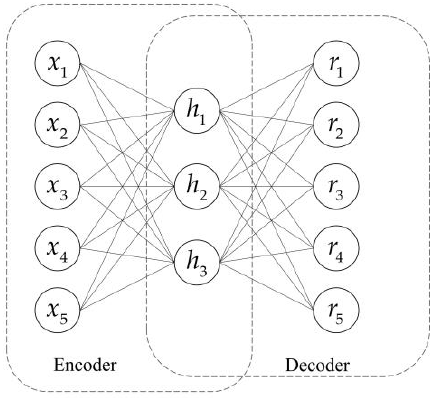
Figure 3. Autoencoder structure diagram.